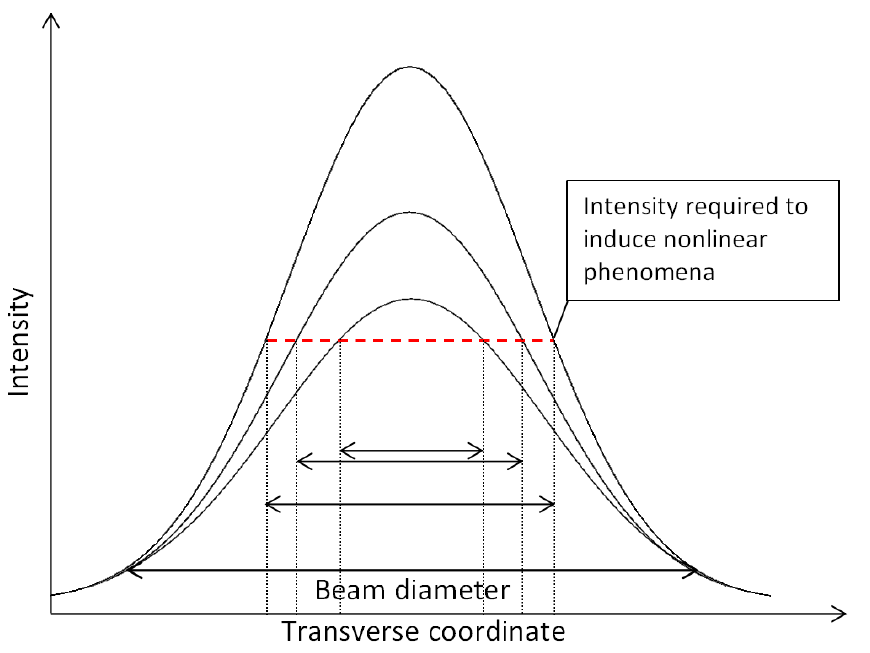
Figure 2. Focused laser beam spot diameter required to induce nonlinear effects dependency on radiation